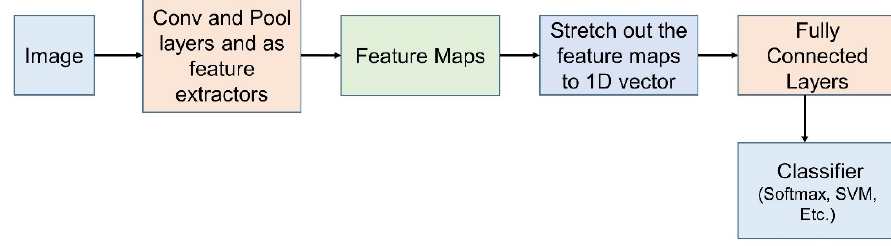
Figure 2. Classification pipeline using CNN.